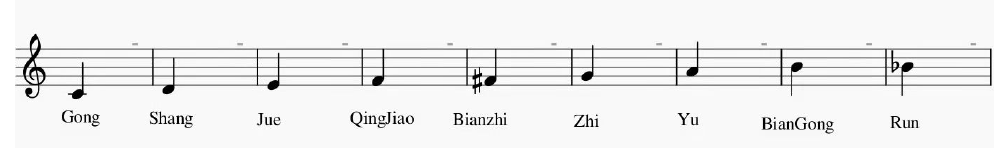
Figure 1. The five main scales and four partial scales in traditional Chinese pentatonic